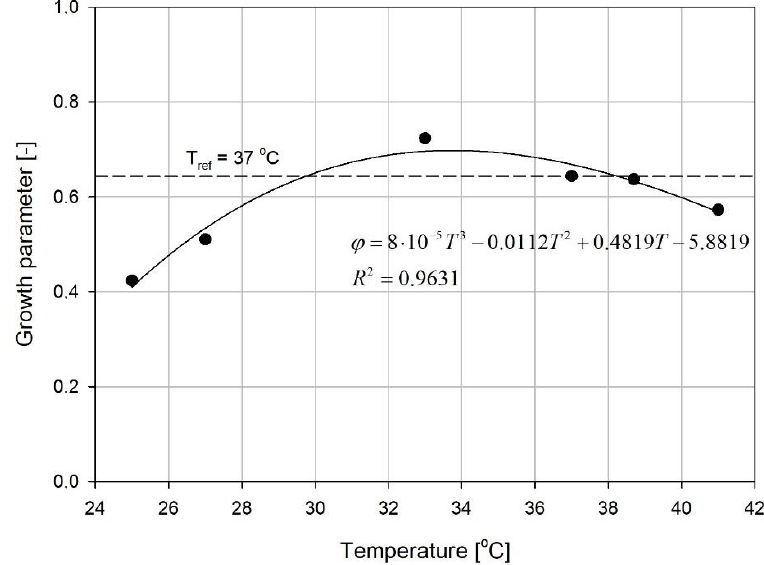
Figure 6. Changes in the growth parameter ϕ of the process temperature. The approximations were